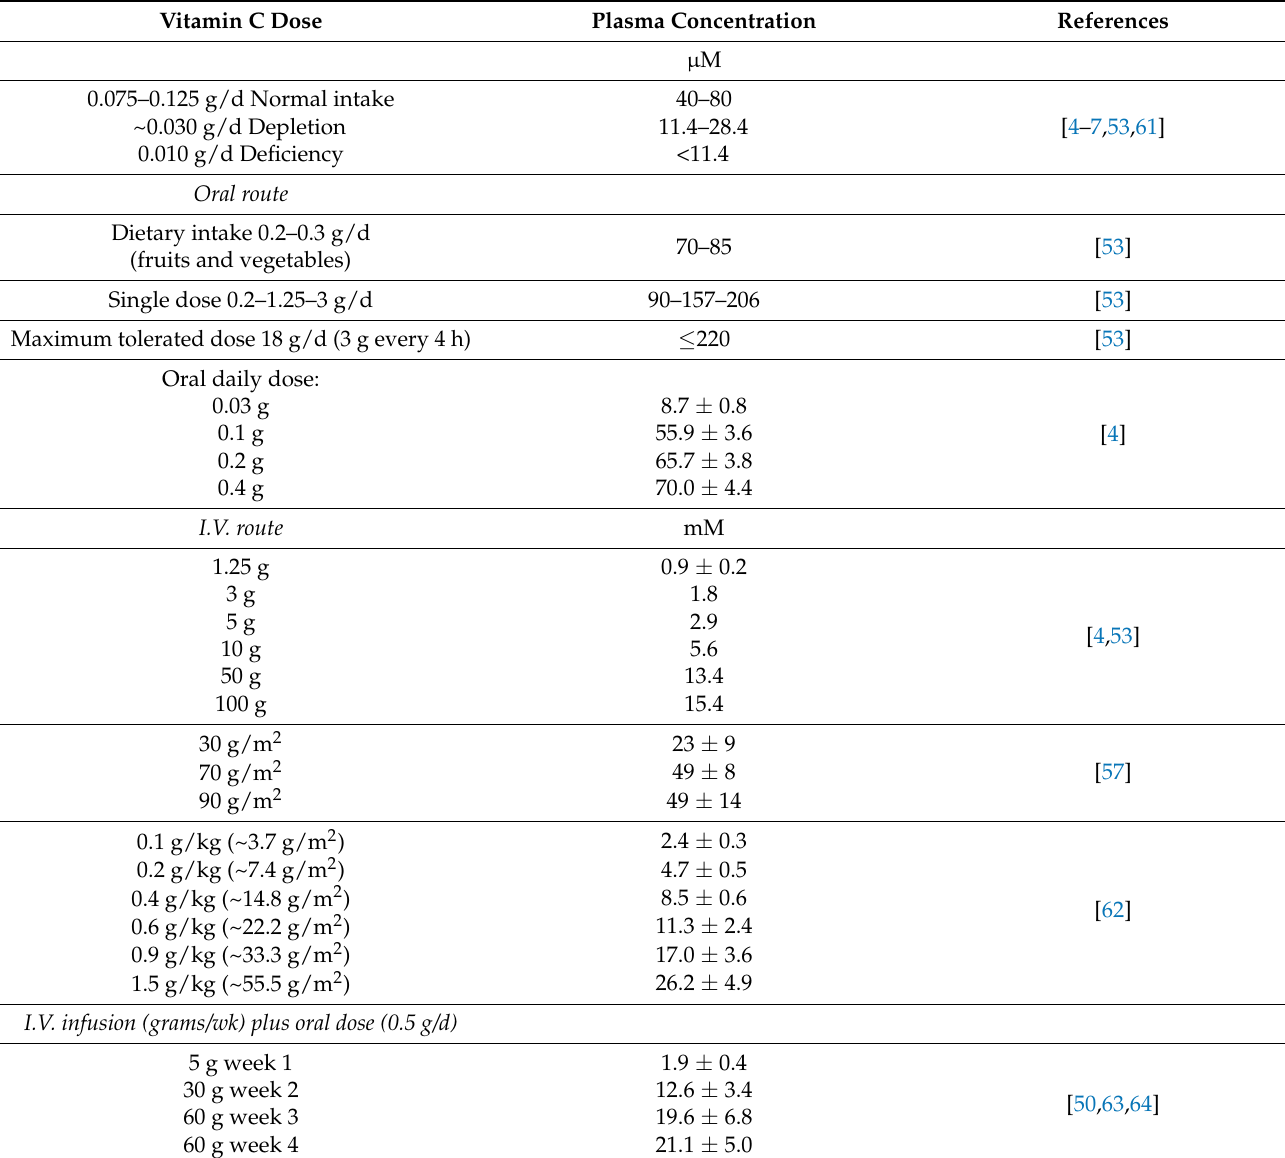
Table 1. Vitamin C plasma concentrations under different conditions and route of